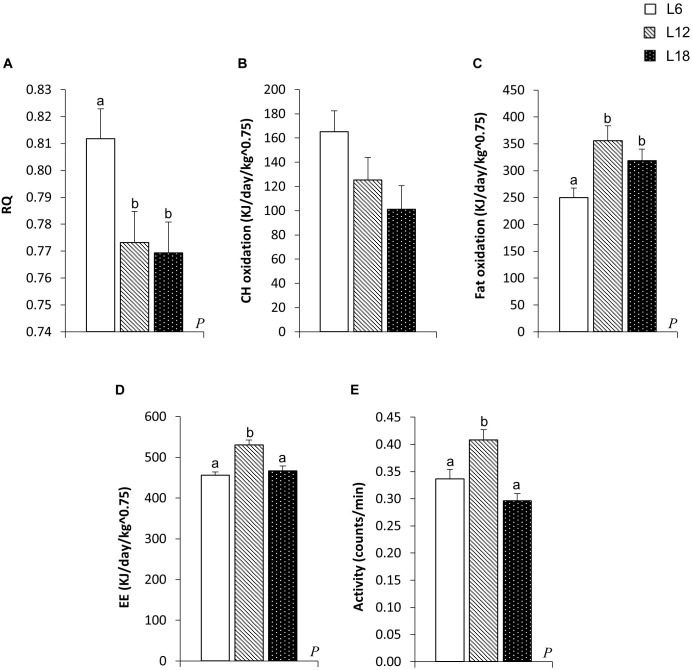
Respiratory quotient (RQ) (A), carbohydrate (CH) oxidation (B), fat oxidation (C), energy expenditure (EE) (D), and locomotor activity (E) in male F344 rats exposed to three different photoperiods for 11 weeks and fed a cafeteria diet for the last 7 weeks. Data are expressed as the mean ± SEM (n = 10). P, photoperiod effect. abMean values with unlike letters were significantly different among groups (one-way ANOVA and Duncan’s post hoc test).